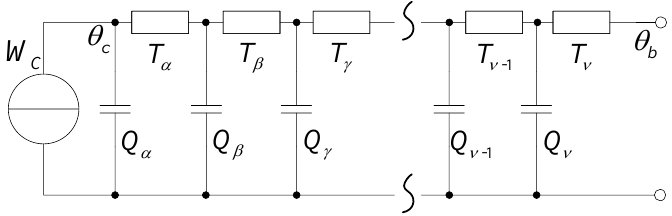
Figure 4. Transient thermal circuit model from boundary to conductor.